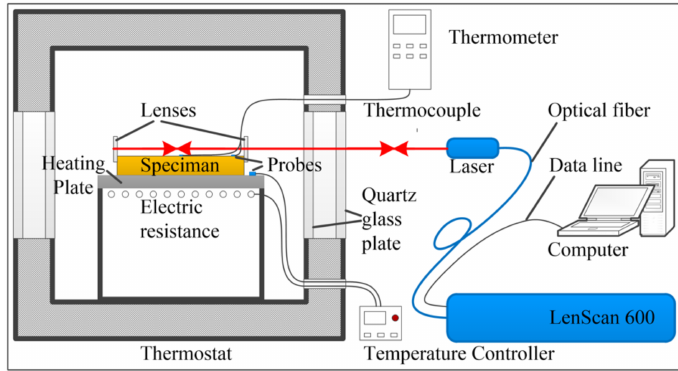
Figure 1. Schematic diagram of the measurement system. It consists of a temperature control system and distance measurement